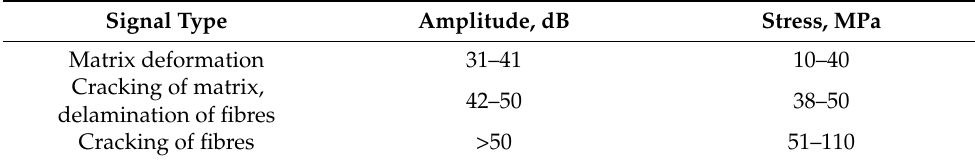
Table 2. Summary of the analysis of the materials degradation.